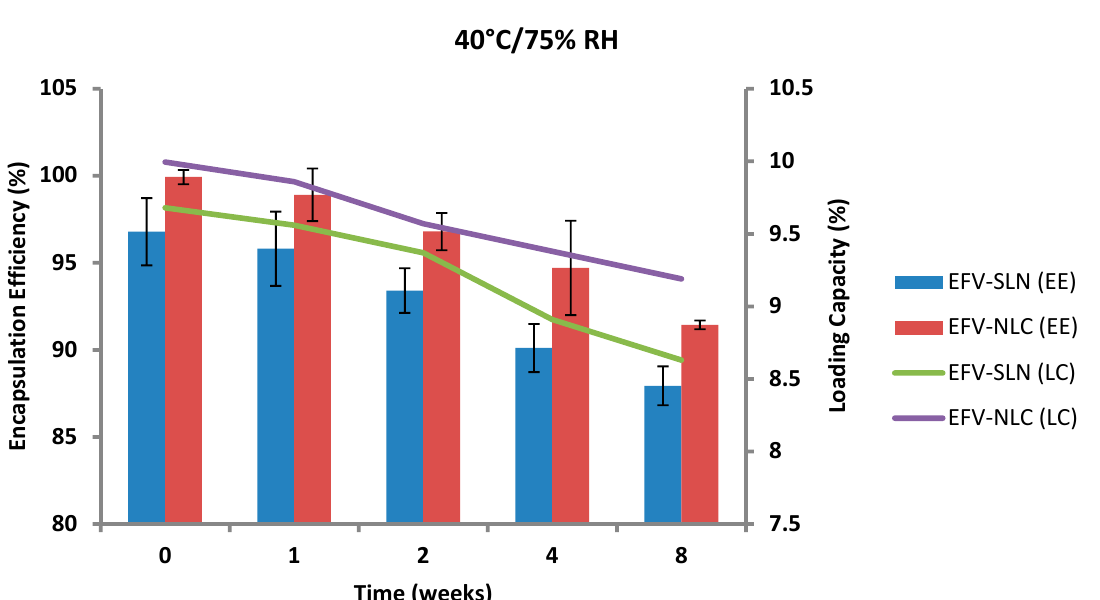
Figure 17. Encapsulation efficiency and loading capacity of SLN and NLC following storage at 25 °C/60% RH .